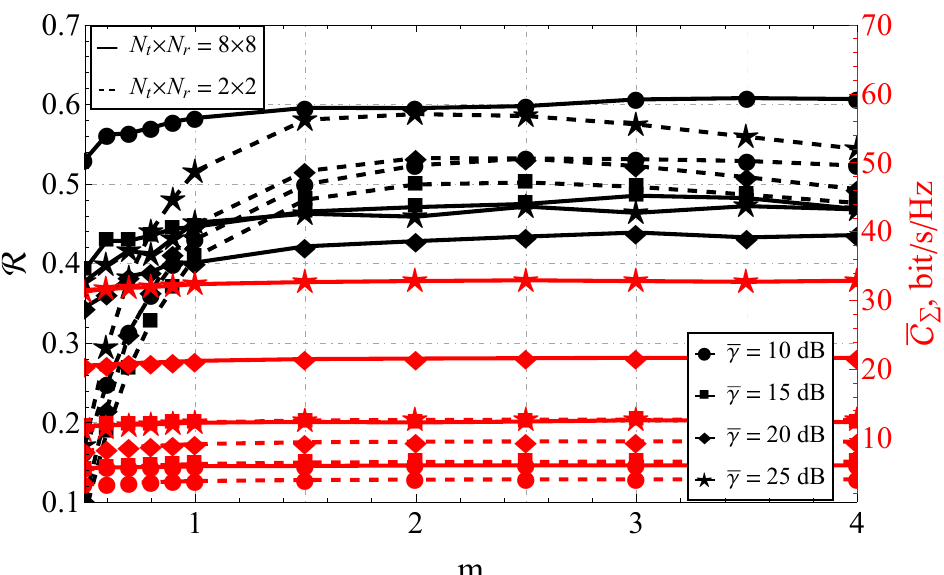
Figure 4. The joint R – C Σ performance of the 8 × 8 and 2 × 2 MIMO systems for various m ’s and different γ